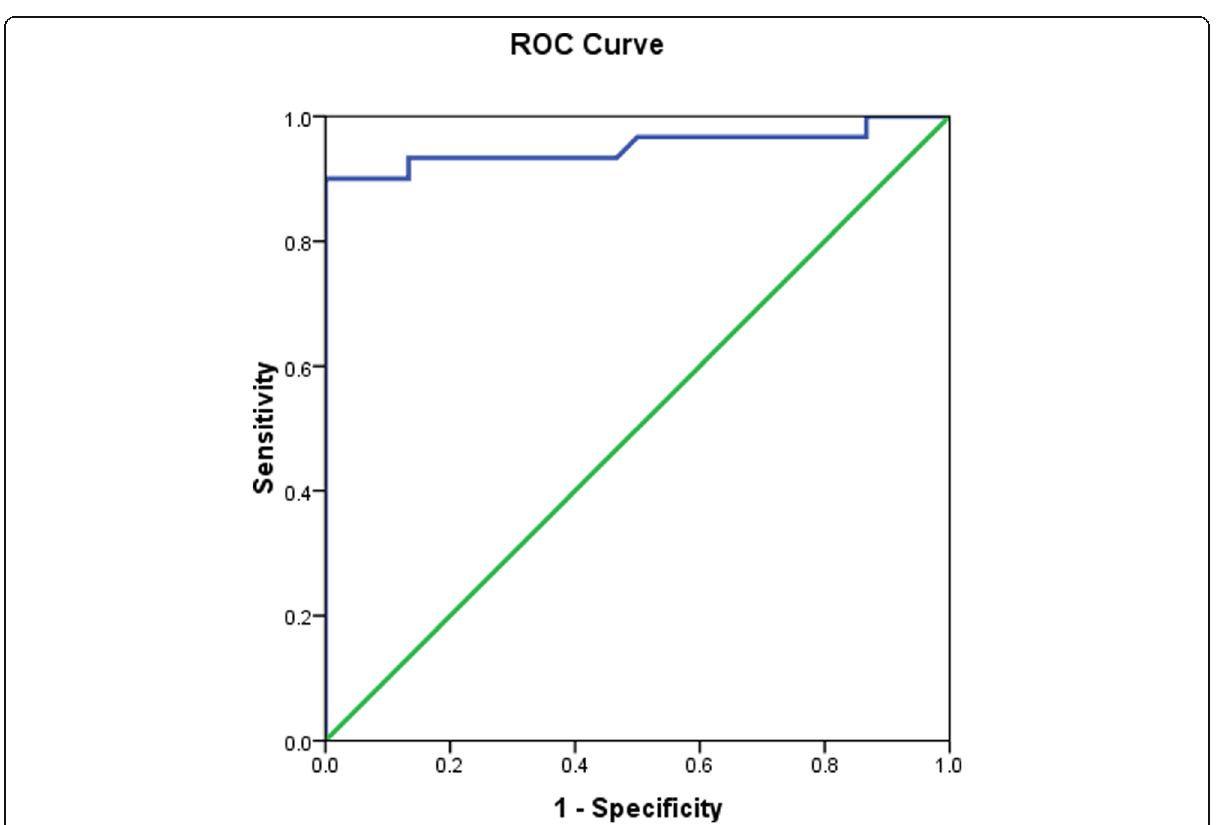
Fig. 7 The area under the receiver operating characteristics curve of telomeric repeat-containing RNA (TERRA) in idiopathic pulmonary fibrosis patients and